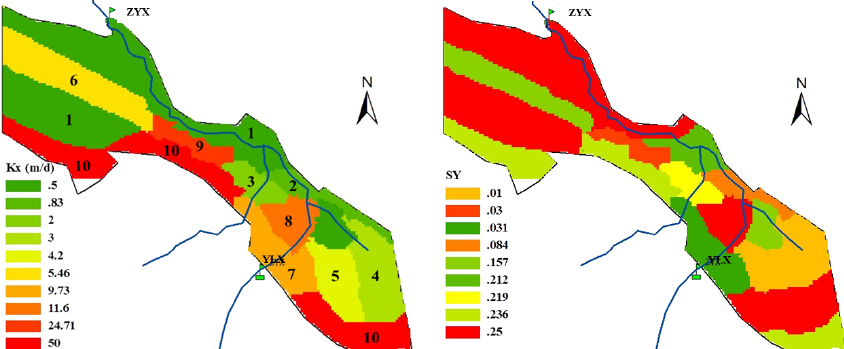
Figure 1. PEST estimated aquifer conductivity K z and specific yield S z